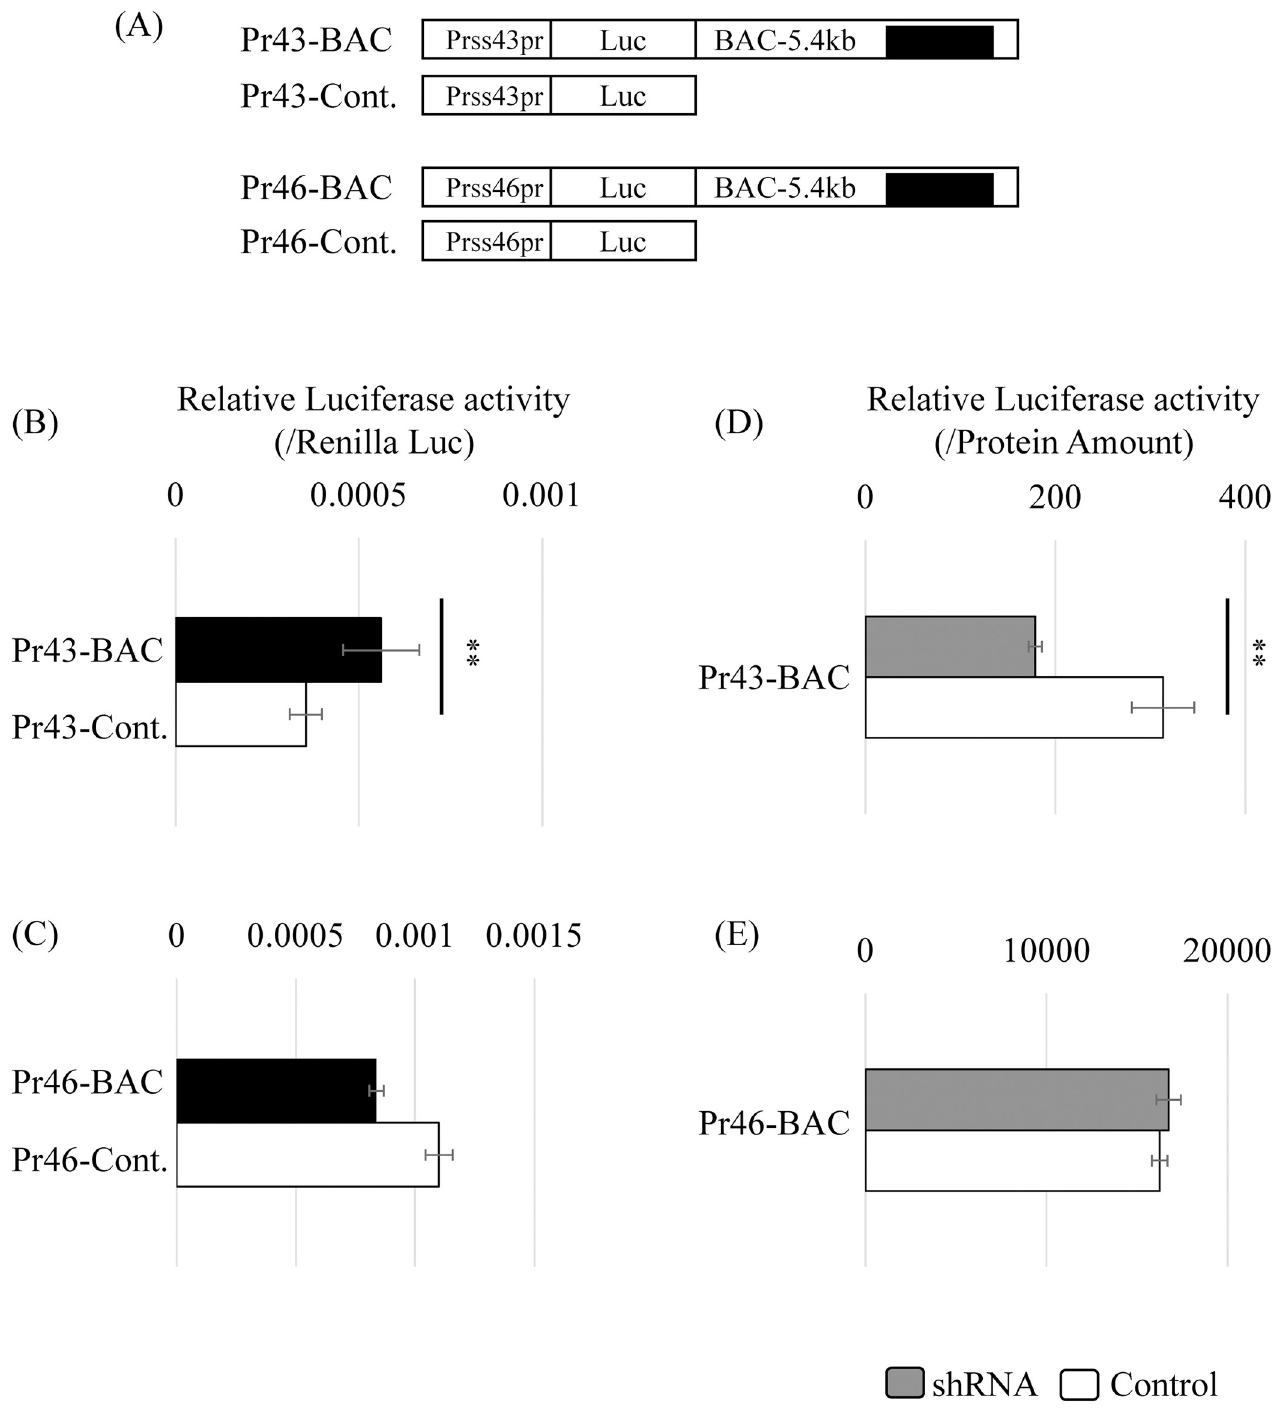
Fig 5. The BAC-5.4kb sequence increased promoter activity of Prss43/Tessp-3 gene. (A) Reporter constructs used in (B)-(E). The promoter sequence of each Prss/Tessp gene was inserted at the upstream of the firefly luciferase gene which was connected to the BAC-5.4kb sequence encompassing Start . (B, C) Enhancer activity of the BAC-5.4kb sequence for Prss43/Tessp-3 and Prss46 promoters by a reporter assay. Each construct depicted in (A) was transfected into GC-2spd(ts) cells, and two days later, firefly luciferase activity was measured. Each value was normalized to that of Renilla luciferase activity, which was derived from a co-transfected construct. Data are presented as means ± S.D. from three independent experiments. Statistical significance was analyzed by Student’s t- test. �� P < 0.01. (D, E) Effects of Start -KD on enhancer activity of the 5.4-kb sequence. Each construct containing BAC-5.4kb in (A) was stably transfected into GC-2spd(ts) cells. The shRNA-v2 for Start was then transfected into the established cells, and after selection with hygromycin, firefly luciferase activity was